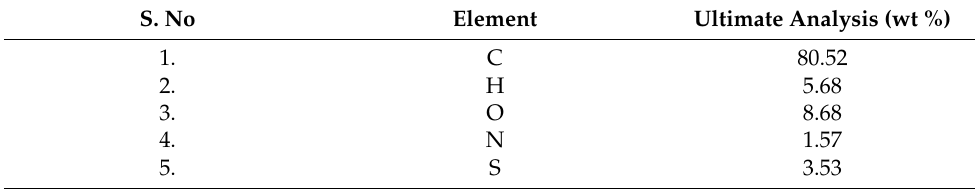
Table 4 . Boundary conditions.